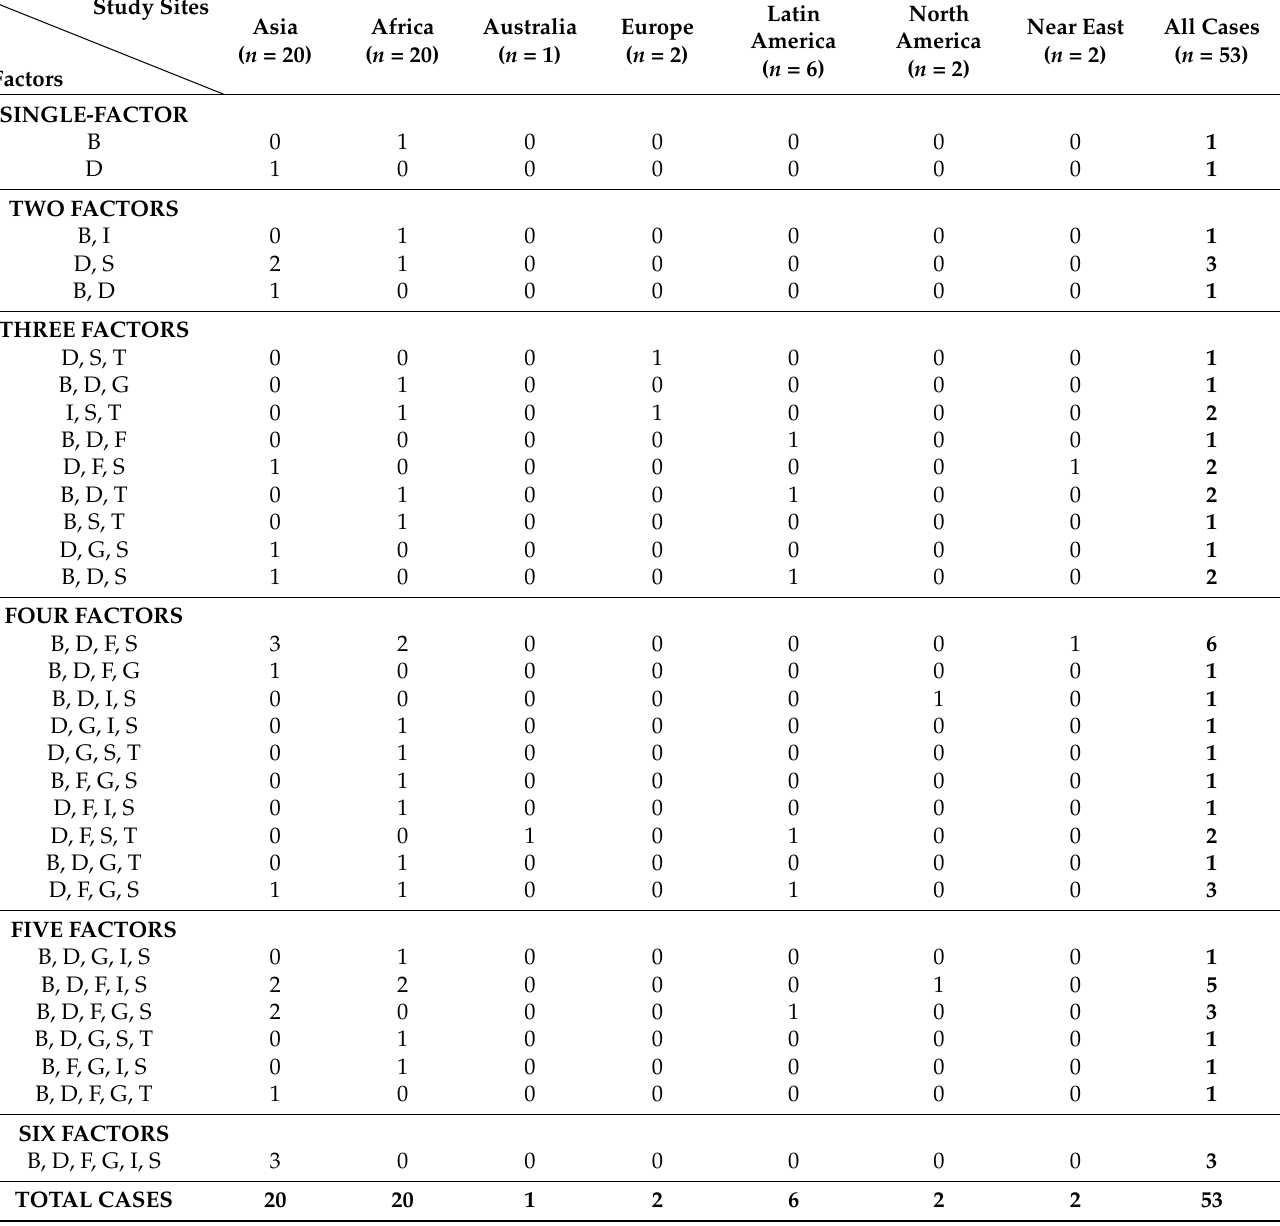
Table 8. Frequency of broad clusters of factors affecting irrigation